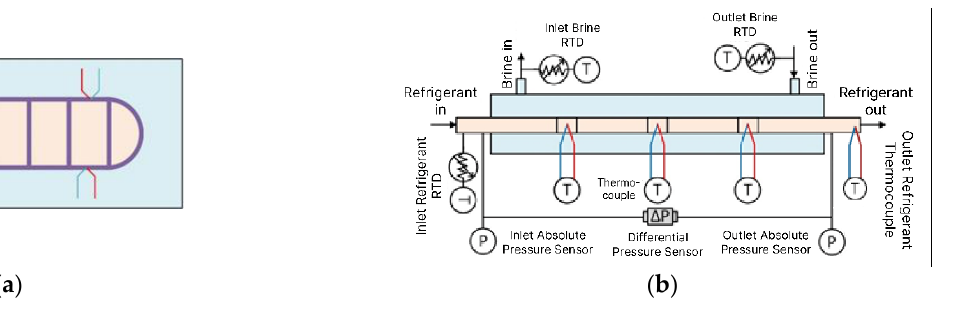
Figure 2. ( a ) Thermocouple attachment positions, ( b ) Test section layout